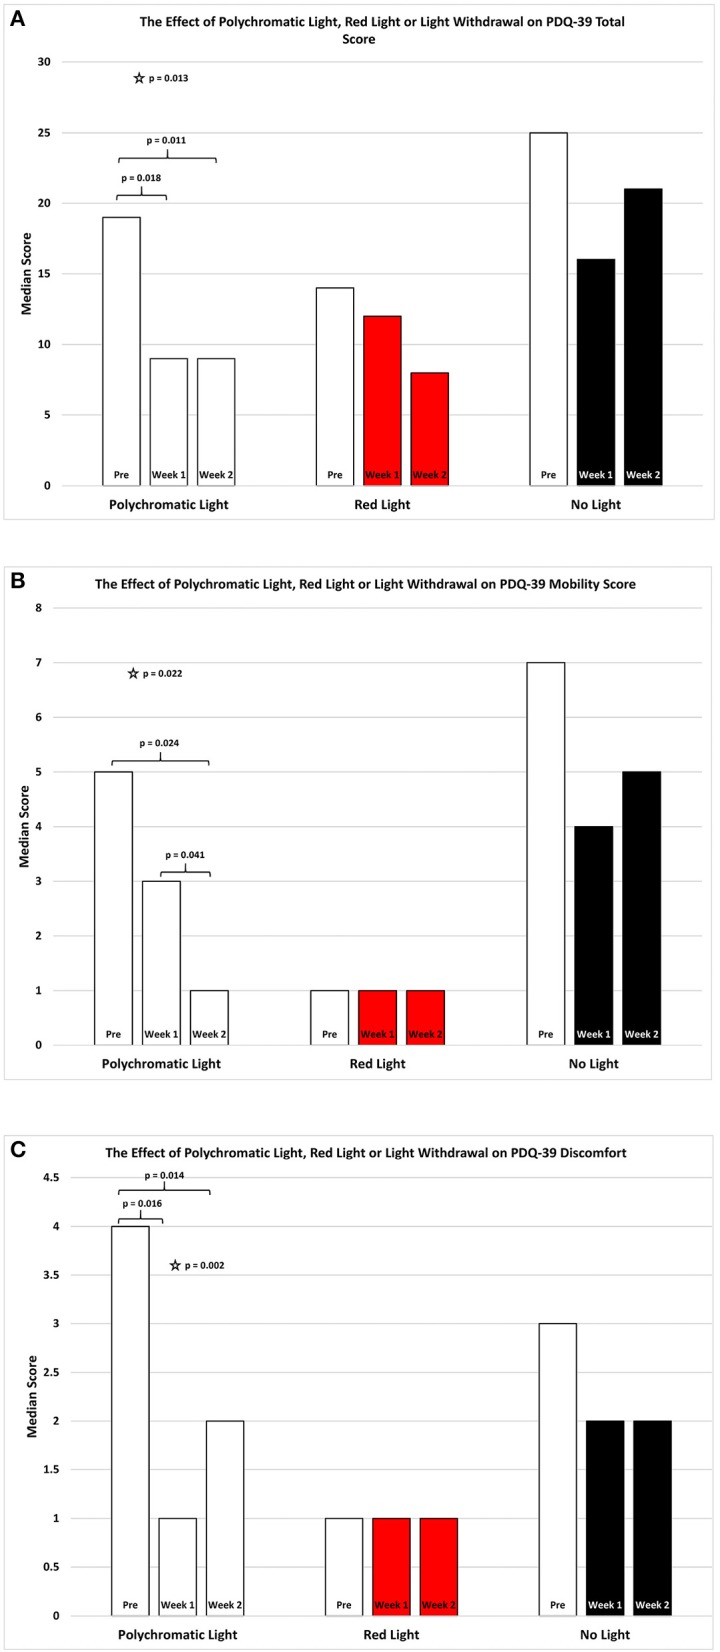
The effect of continued daily exposure to polychromatic light, red light or withdrawal of polychromatic light on the Total Score (A), Mobility (B) and Discomfort (C) sub-sections of the PDQ-39 is expressed as the median score for each group after 3 assessments over a 2 week period. The pre-score served as the baseline and was obtained when the study commenced and before patients were randomly assigned to their respective treatment groups. The inclusion bars show significant statistical comparisons with p-values indicating the levels of significance obtained. Statistical comparisons were made between baseline (Pre) and Week 1, Pre and Week 2 and Week 1 and Week 2. Significant levels were determined a priori with a significant effect defined as p ≤ 0.05 regarded while trends were designated as p values ranging from 0.051 to 0.099. The star represents a significant overall effect using the Friedman's Two Way ANOVA while the inclusion bars mark significant comparisons using the Wilcoxon Signed Rank Test.